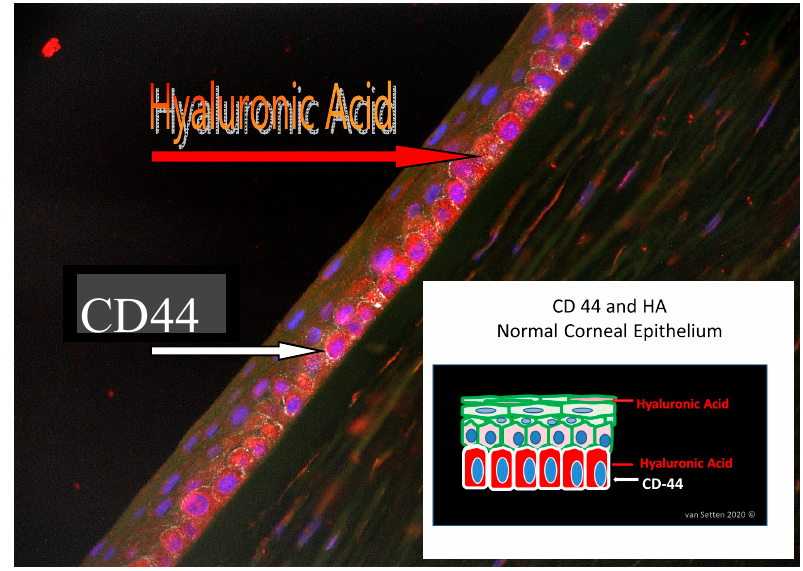
Figure 3. Histology picture identifying HA and CD 44 in human corneal epithelium. The schematic drawing illustrates the localization of HA (stained in red) within the cells and in the ECM even in the wing-cell layer, whereas CD44 (stained in white) is more concentrated in the basal cell layer.